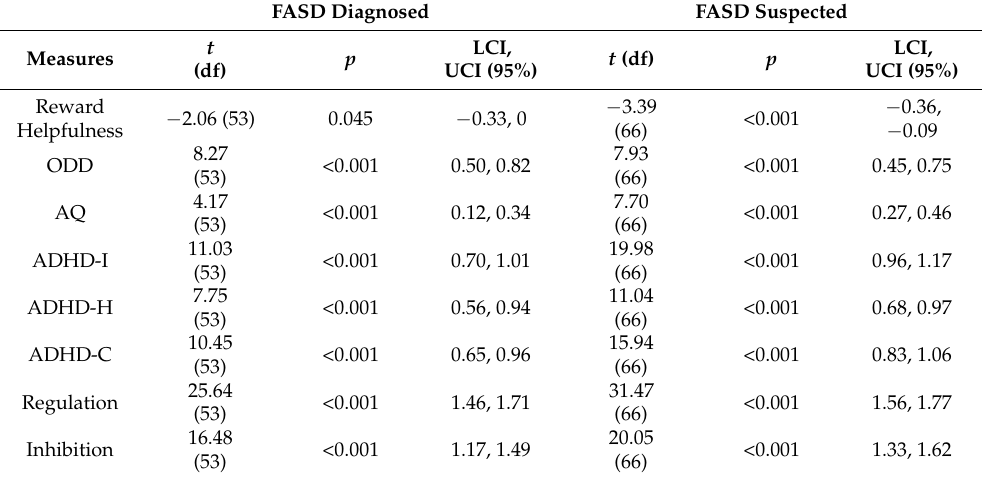
Table A1. Showing the results of the one-sample t -Test indicating a difference from the median scale score for each measure, in the two FASD diagnostic groups (suspected and diagnosed). All results are